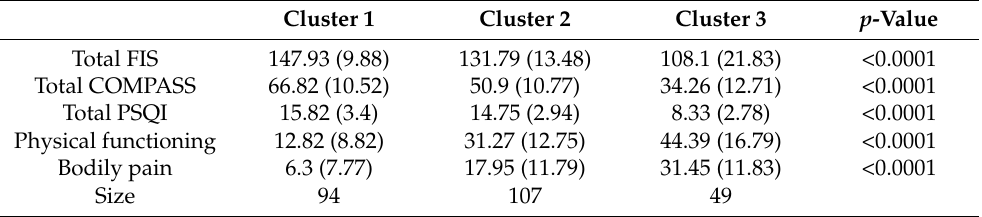
Table 2. Clustering of ME/CFS cases according to symptom differences, as supported by k-means analysis. Data are presented as the mean ± SD for each item. Physical functioning and bodily pain were evaluated by two items of the 36-item Short-Form Health Survey